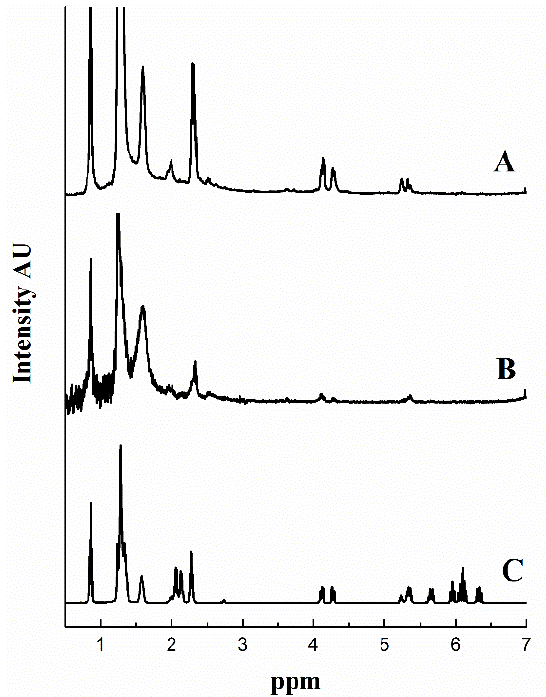
Figure 10. 1 H NMR spectra of (A) tung oil-based resin cured for 6 h at 140 °C in a convection oven without CNTs, (B) tung oil-based resin reinforced with 0.25 wt %